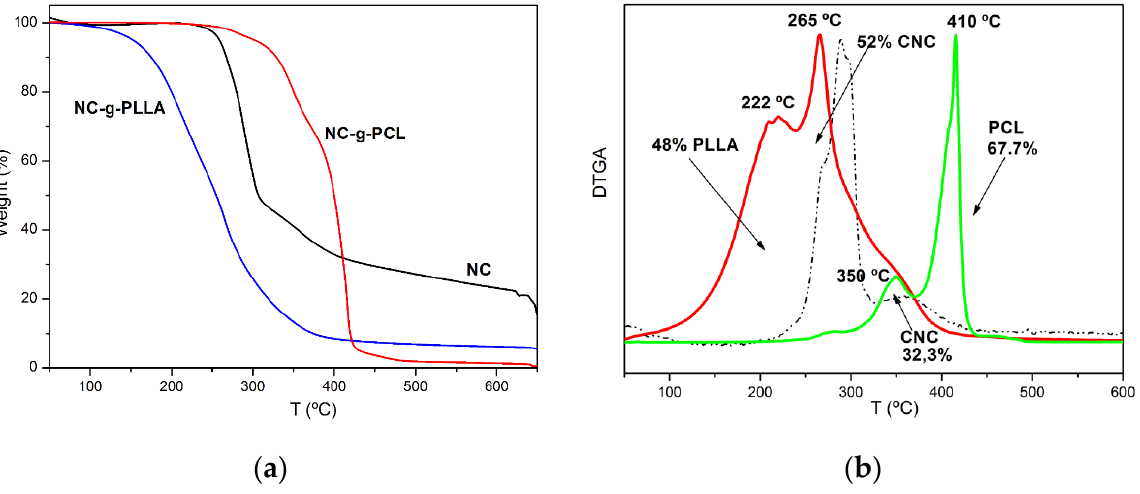
Figure 3. Weight loss curves ( a ) and DTGA thermograms ( b ) for: neat cellulose NC (black), NC-g-PCL (green), and NC-g-PLLA (red).